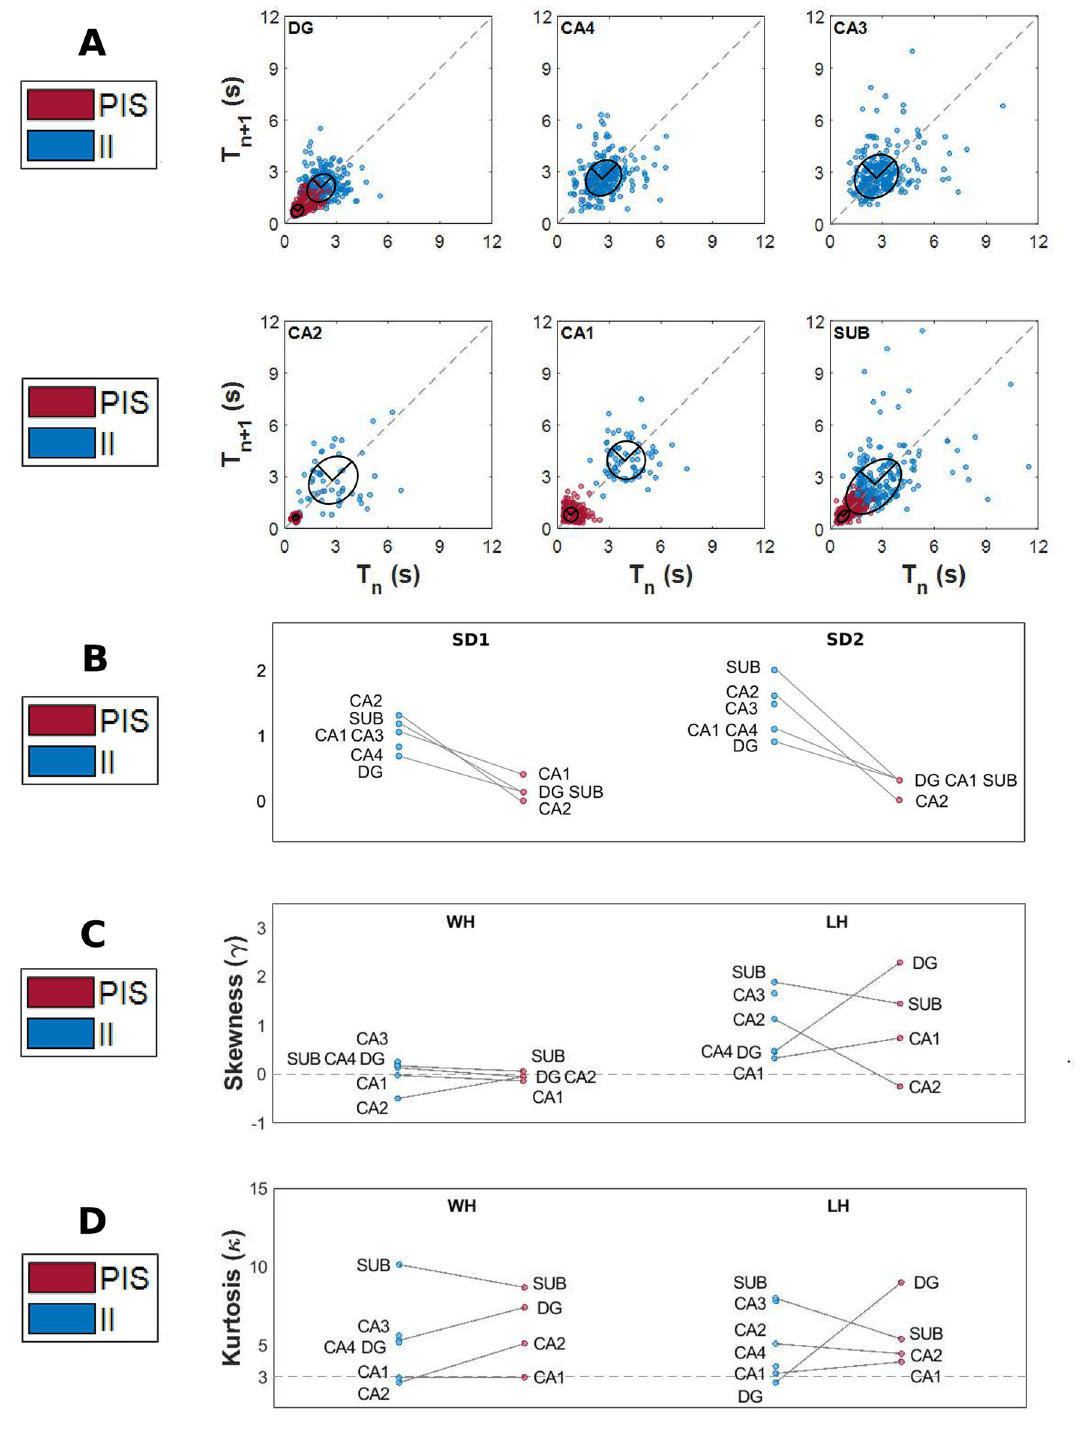
Fig 5. Spread pattern of interspike intervals into hipocampal subfields. (A) Poincare´ map for each hippocampal subfield containing the interspike interval spread patterns. (B) Slope graphs of SD1 and SD2 values for each hippocampal subfield. (C) Slope graphs of skewness values of width ( γ ) and length ( γ ) histograms for each hippocampal subfield. (D) Slope graphs of kurtosis WH LH values of width ( κ WH ) and length ( κ LH ) histograms for each hippocampal subfield.